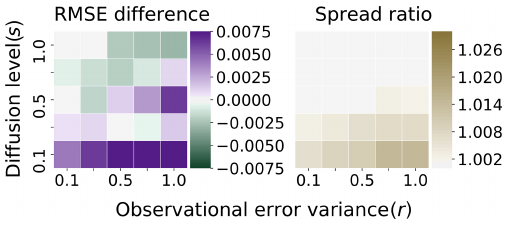
Figure 9. Truth: Taylor (cid:49) t = 5 × 10 − 3 . Ensemble: Runge–Kutta (cid:49) e = 10 − 2 . Difference in RMSE/ratio of spread with benchmark Fig. 5.